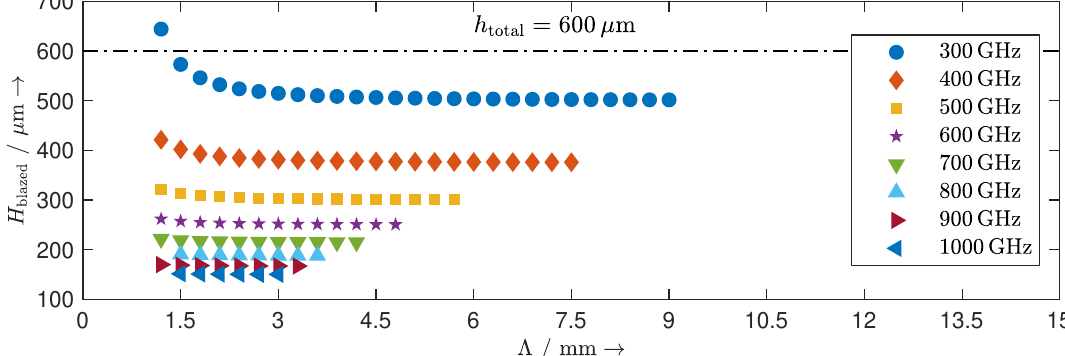
Figure 2. Required heights of the MEMS reflectors for the blazed gratings at different